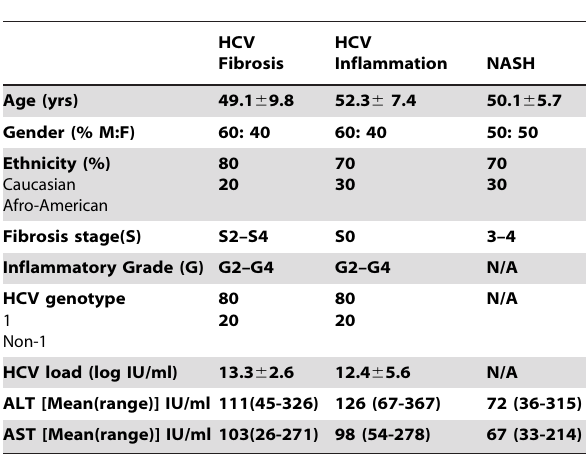
Table 1. Demographics of the